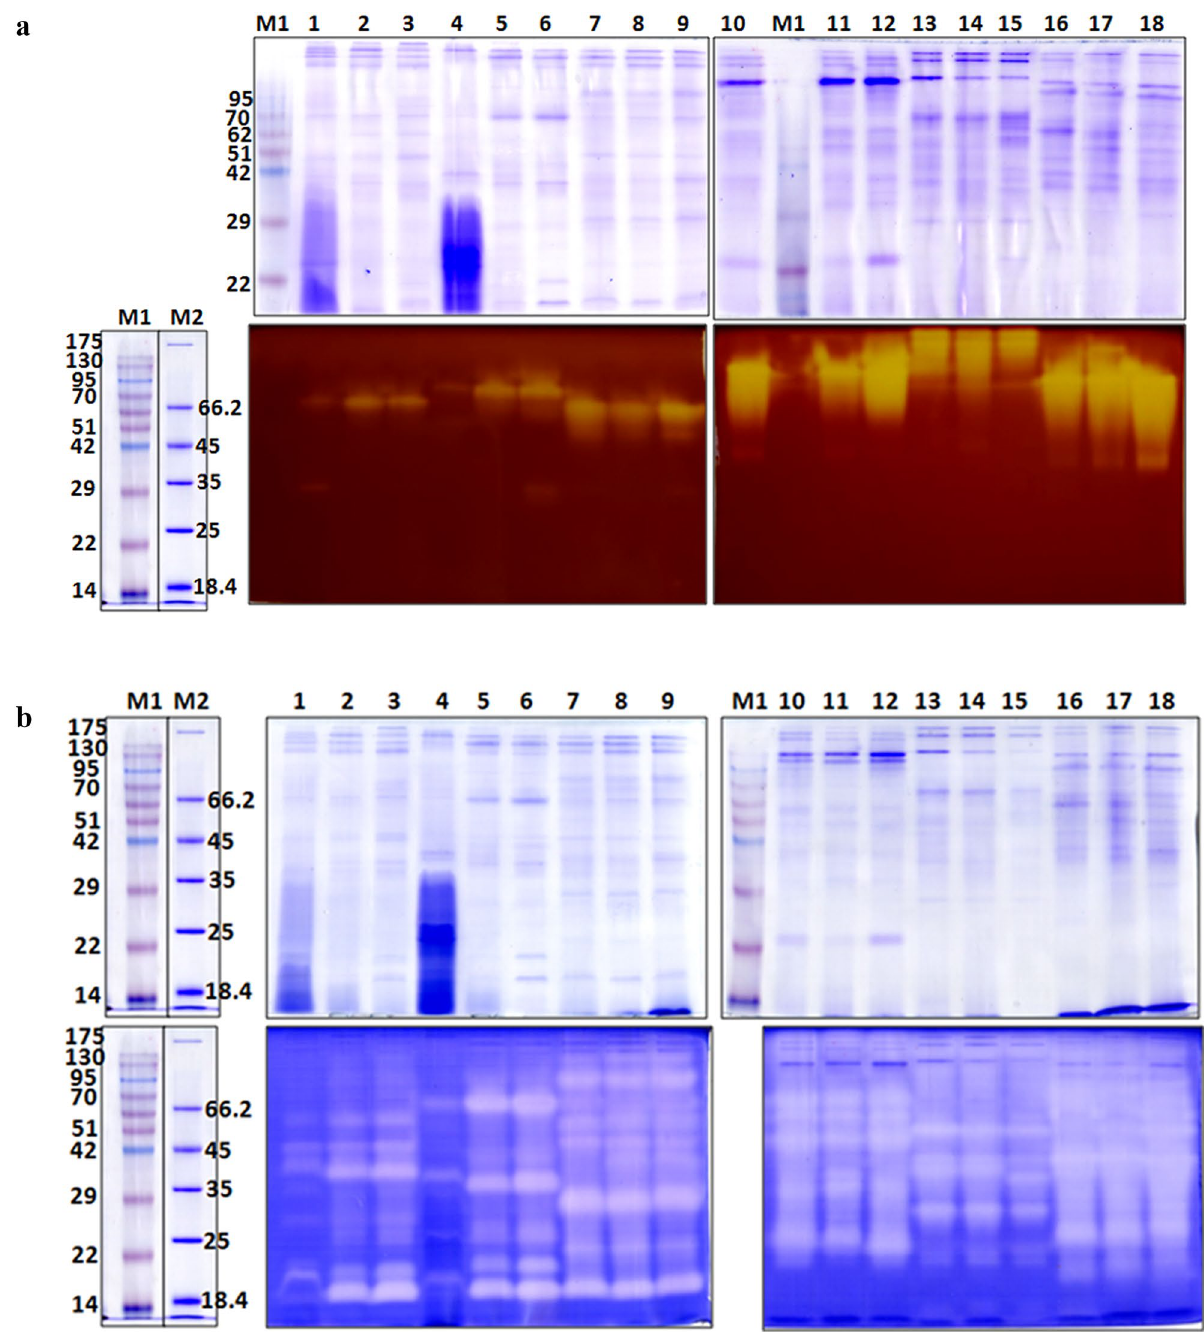
Figure 3. SDS gels stained with Coomassie brilliant blue R-250 and zymograms of amylase ( a ), alkaline proteases ( b ) (Lane M1; Pink plus prestained protein ladder (GeneDireX), lane M2; unstained protein molecular weight marker (Thermo Scientific), lanes 1–3; Ompok bimaculatus (n6, n7, n8), lanes 4–6; Kryptopterus geminus (n6, n7, n8), lanes 7–9; Hemibagrus spilopterus (n1, n2, n4), lanes 10–12; Puntius gonionotus (n5, n7, n8), lanes 13–15; Oreochromis niloticus (n5, n7, n8), lanes 16–18; Puntioplites proctozysron (n1, n2,